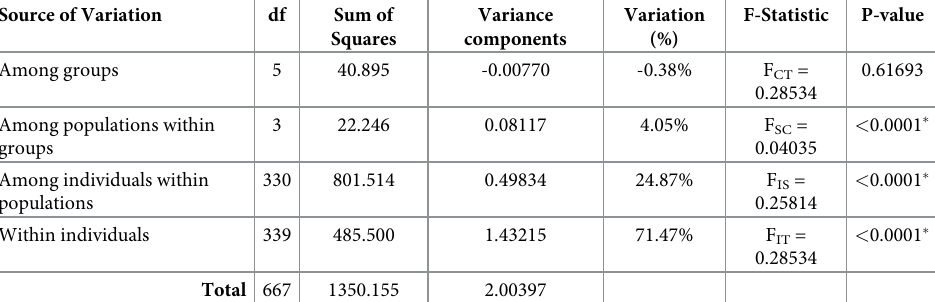
Variance Variation F-Statistic P-value Squares components (%)